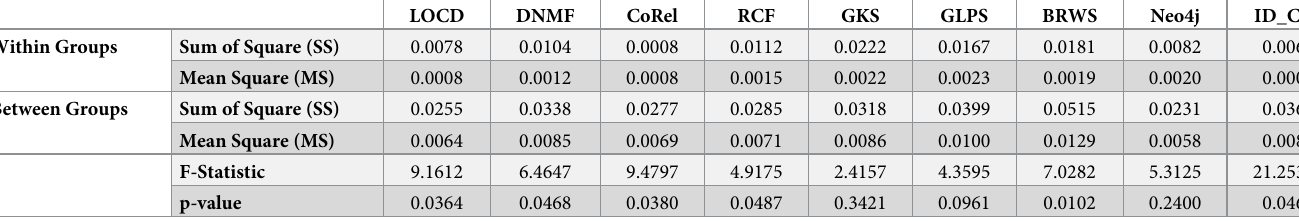
Table 3. One way ANOVA table for the overall average values of the ARI